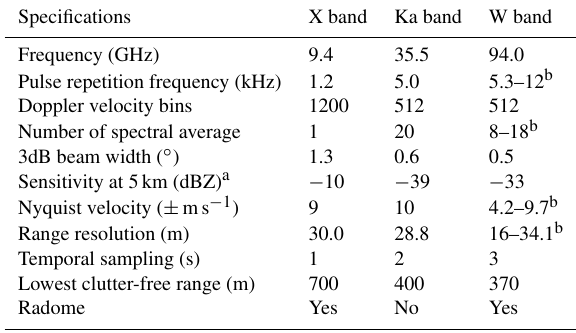
Table 1. Technical specifications and settings of the three vertically pointing radars operated during TRIPEx at